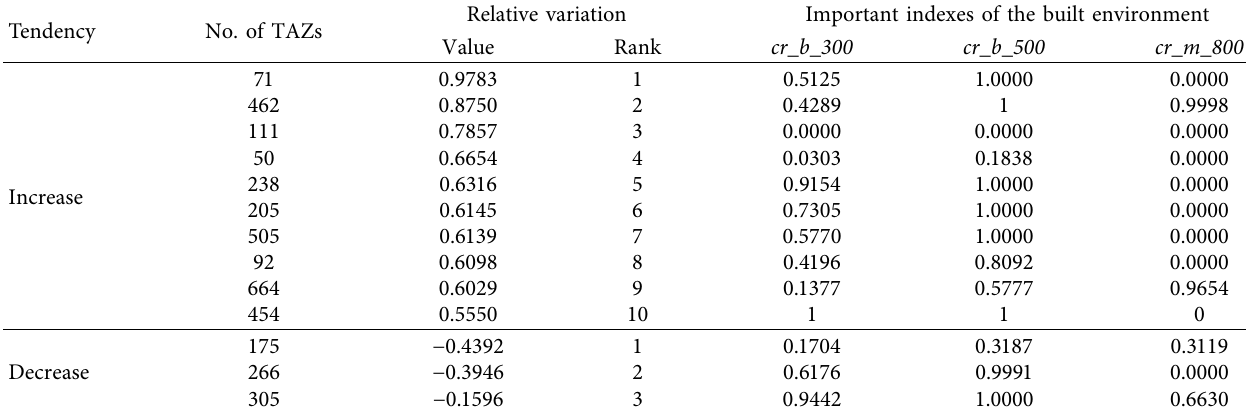
Table 4: Significantly influenced regions ordered by the variation in taxi